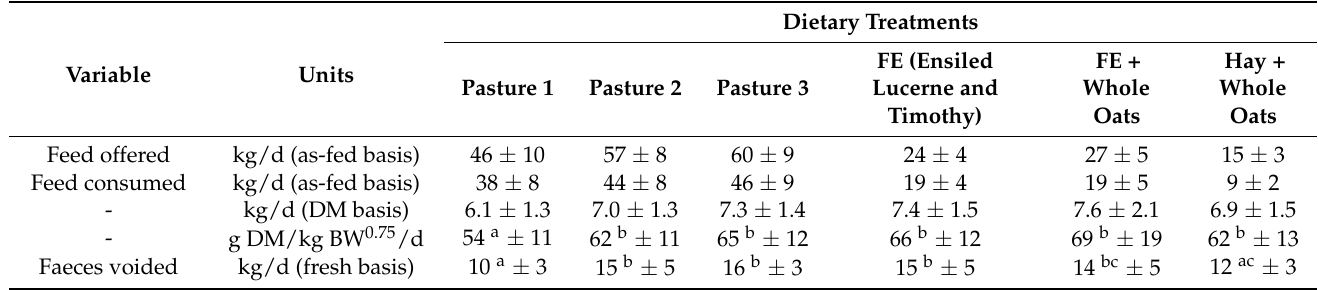
Table 2. Feed offered and consumed by the horses during the study period and faecal